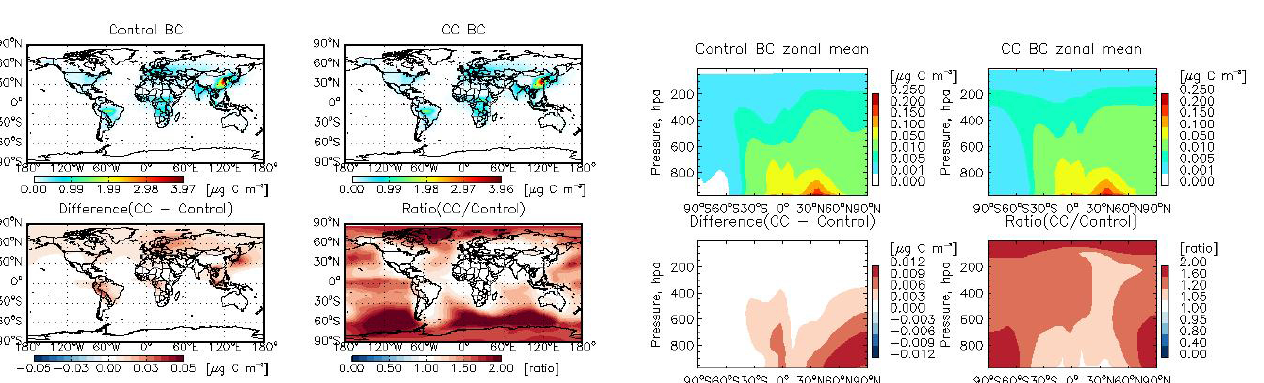
Fig. 5b. Same as Fig. 5a but for OC.